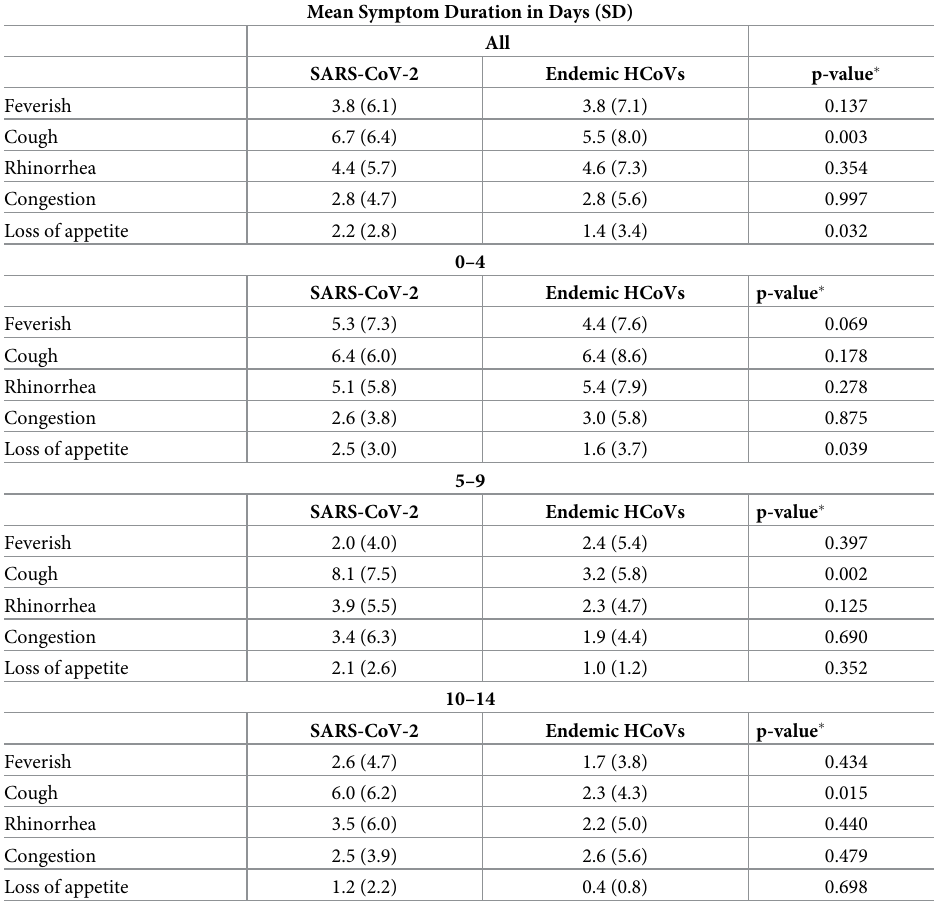
Table 4. Symptom duration comparison: SARS-CoV-2, endemic